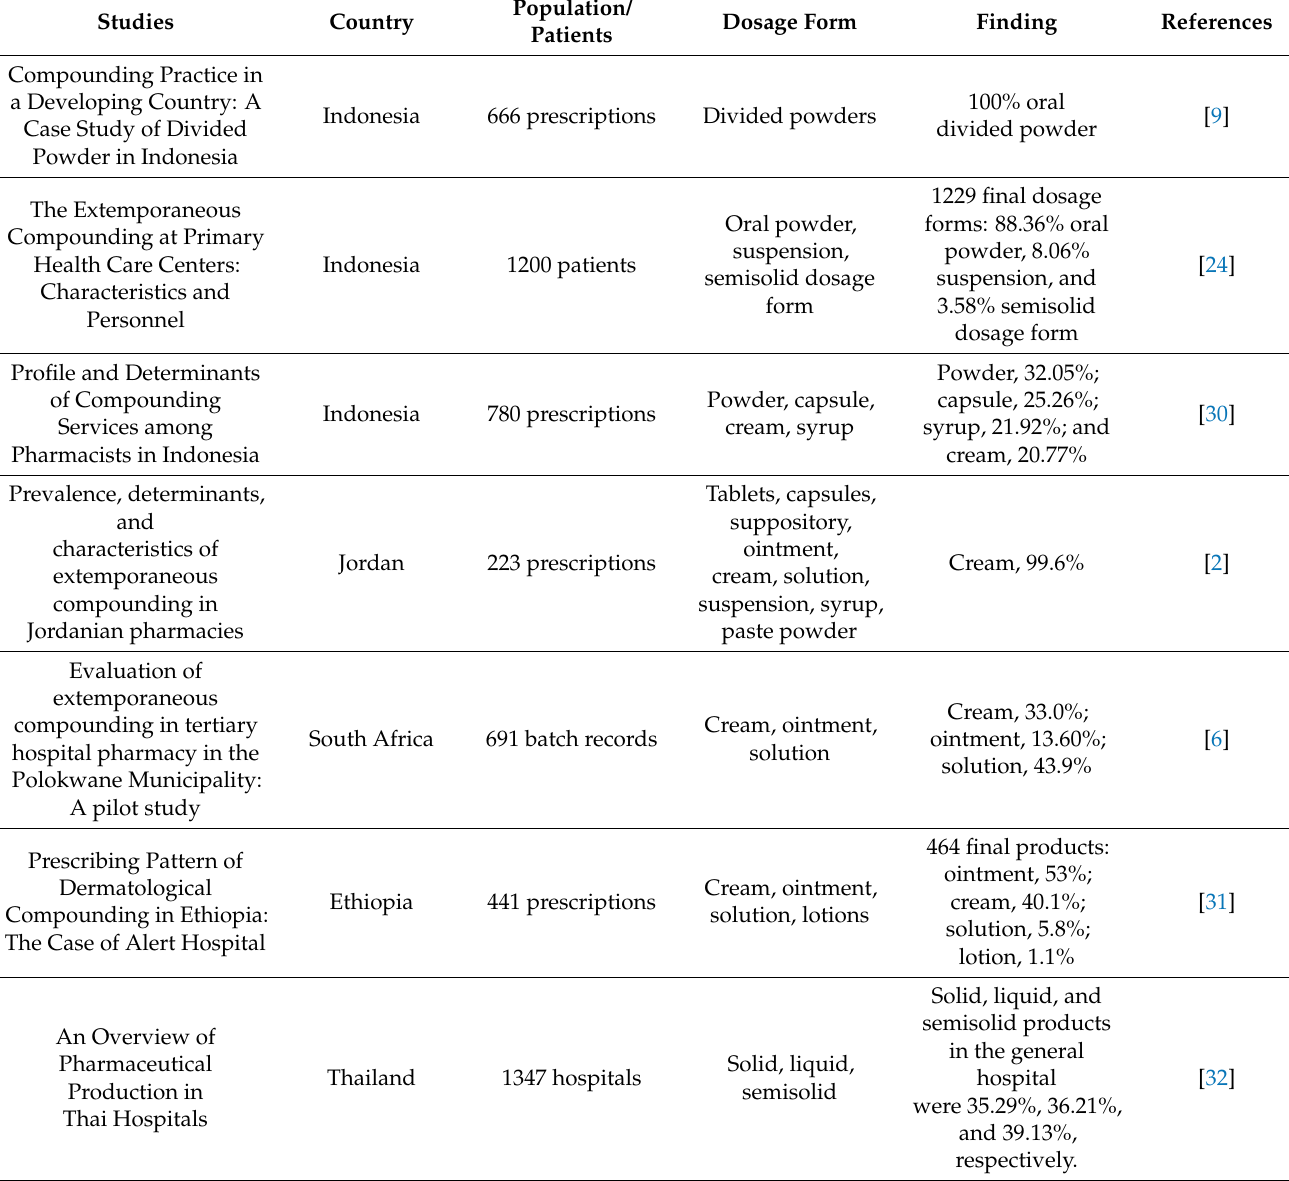
Table 1. Compounding reports related to non-sterile extemporaneous products and their proportions in developing